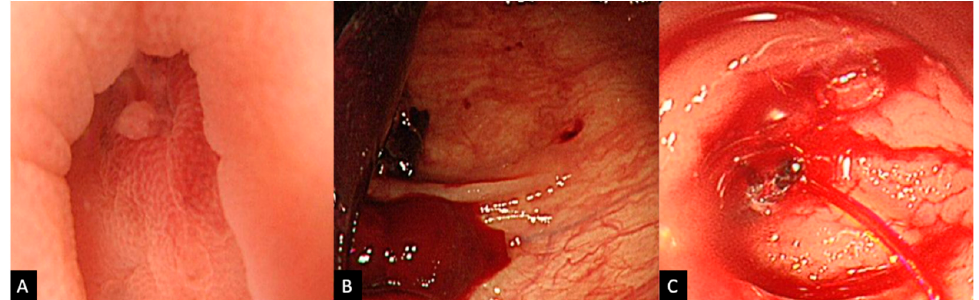
Figure 1. Stigmata of recent hemorrhage for diverticular bleeding. ( A ) A non-bleeding visible vessel within a diverticulum. ( B ) Adherent clot covering the opening of a diverticulum. ( C ) An active bleeding vessel.